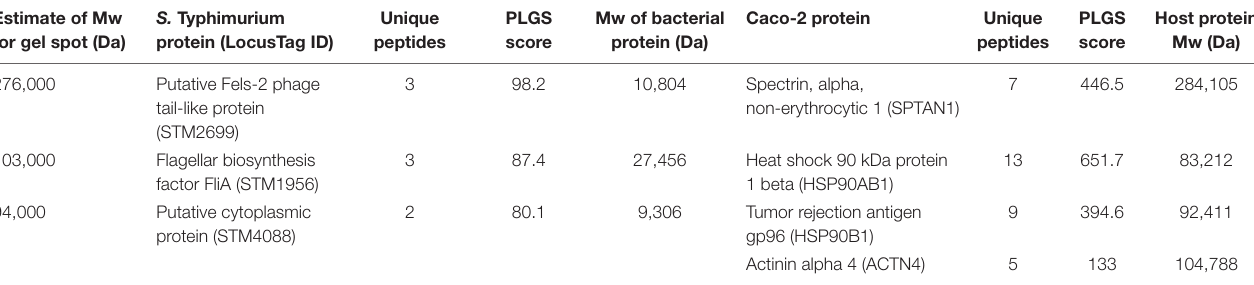
TABLE 4 | Host/microbe binding partner proteins identified using whole cell cross-linking. Estimate of Mw for gel spot (Da)